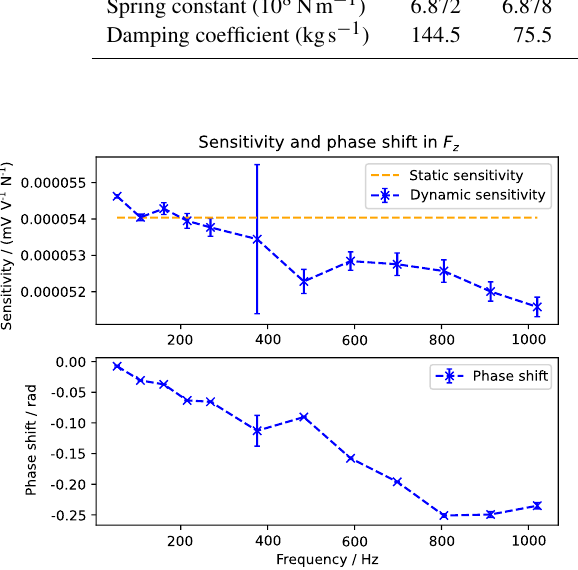
Figure 14. Sensitivity of F z and phase shift between top mass ac- celeration and sensor signal. Error bars represent the standard de- viation for the acceleration at eight different positions on the top